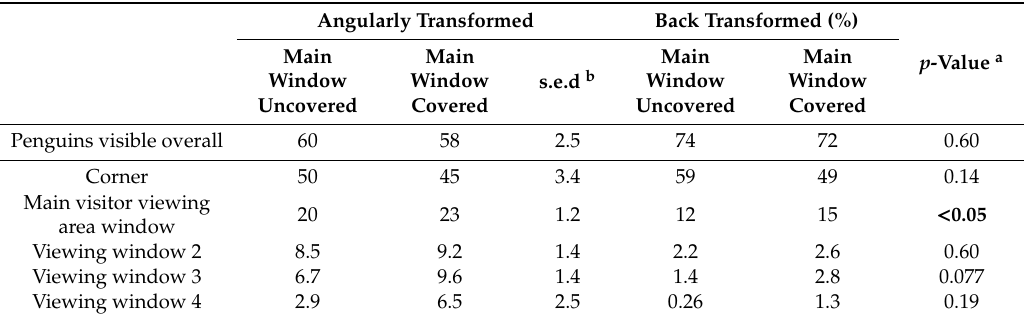
Table 5. The e ff ect of treatment on the proportion of penguins visible (%) overall and the proportion of penguins visible in each area near the four visitor viewing area windows and the ‘Corner’. Data were angularly transformed. Any statistical significance ( p < 0.05) are